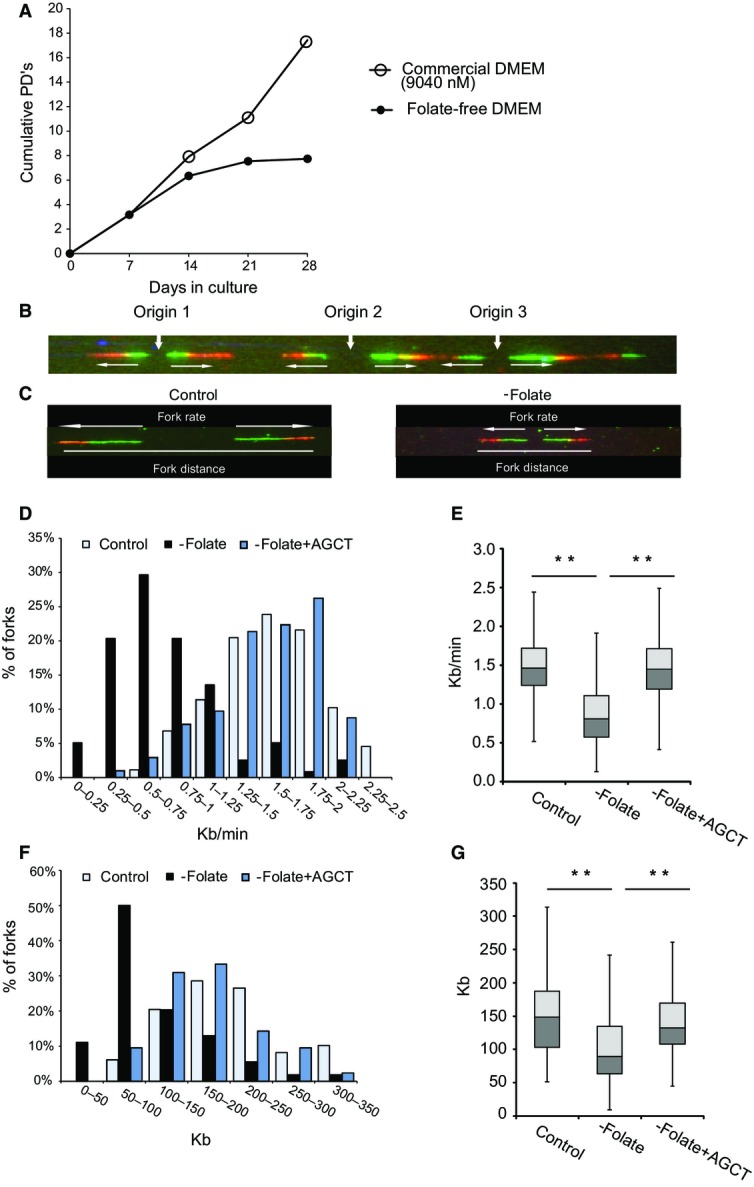
Growth rate and replication dynamics in BJ cells grown in a folate-free medium with and without nucleoside supplementation
Population doublings (PDs) determined in BJ cells cultured with and without folate for 28 days.

Example of a single combed DNA molecule labeled with IdU (green) and CldU (red), showing replication from three adjacent origins. Horizontal white arrows indicate fork orientation.

Representative examples of single combed DNA molecules from control cells and cells grown for 7 days in a folate-free medium.

Fork rate (Kb/min) distribution. Light blue bars: BJ cells (n = 126); black bars: BJ cells that were cultured for 7 days in a folate-free medium (n = 131); blue bars: BJ cells cultured for 7 days in a folate-free medium and supplemented with A, G, C, and T nucleosides for the last 48 h of the experiment (n = 138).

Box plot summarizing the fork rate distribution (Kb/min) of three independent experiments. Control (n = 360); −folate (n = 372); −folate + AGCT (n = 361).

Fork distance (Kb) distribution. The color code is as in (D). Control (n = 72); −folate (n = 71); −folate + AGCT (n = 75).

Box plot summarizing the fork distance distribution (Kb) of three independent experiments. Control (n = 212); −folate (n = 215); −folate + AGCT (n = 209).
Data information: (E, G) Main box represents the values from the lower to upper quartile (25th to 75th percentile). The middle line represents the median. **P < 0.0001.